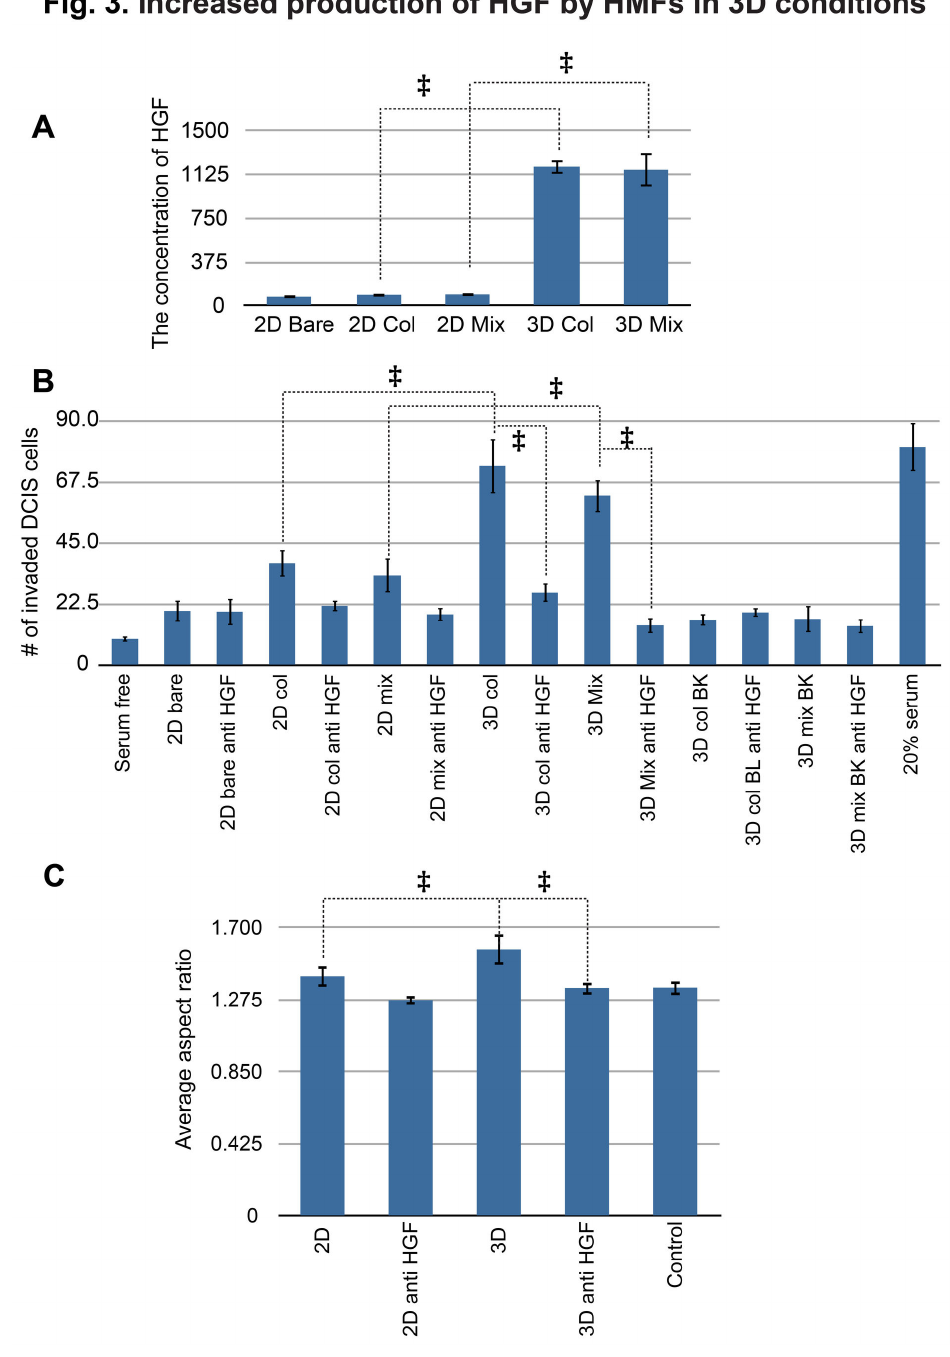
Figure 3. Increased production of HGF by HMFs in 3D conditions. (A) An ELISA assay showing the concentration of HGF [pg/ml] in different conditioned media collected from three 2D conditions (bare, collagen-coated, mixed matrix-coated), and two 3D conditions (collagen I only, mixed matrix). HMF cells in all 3D conditions significantly increased the secretion of HGF. ‡ represents a p value of less than 0.05. (B) Invasion of MCF-DCIS cells with HGF neutralizing antibody (anti HGF) using transwells. The HGF neutralizing antibody (0.5 μg/ml) is added to various 2D CM, 3D CM and BK CM (the conditioned medium collected from blank mixed gels). A serum free medium is used as a negative control and a 20% serum-containing medium is used as a positive control. ‡ represents p value of less than 0.05. (C) The aspect ratio of MCF-DCIS cells cultured in a 3D condition with 2D CM and 3D CM with or without the HGF neutralizing antibody. ‡ represents a p value of less than 0.05. doi: 10.1371/journal.pone.0076373.g003 PLOS ONE |